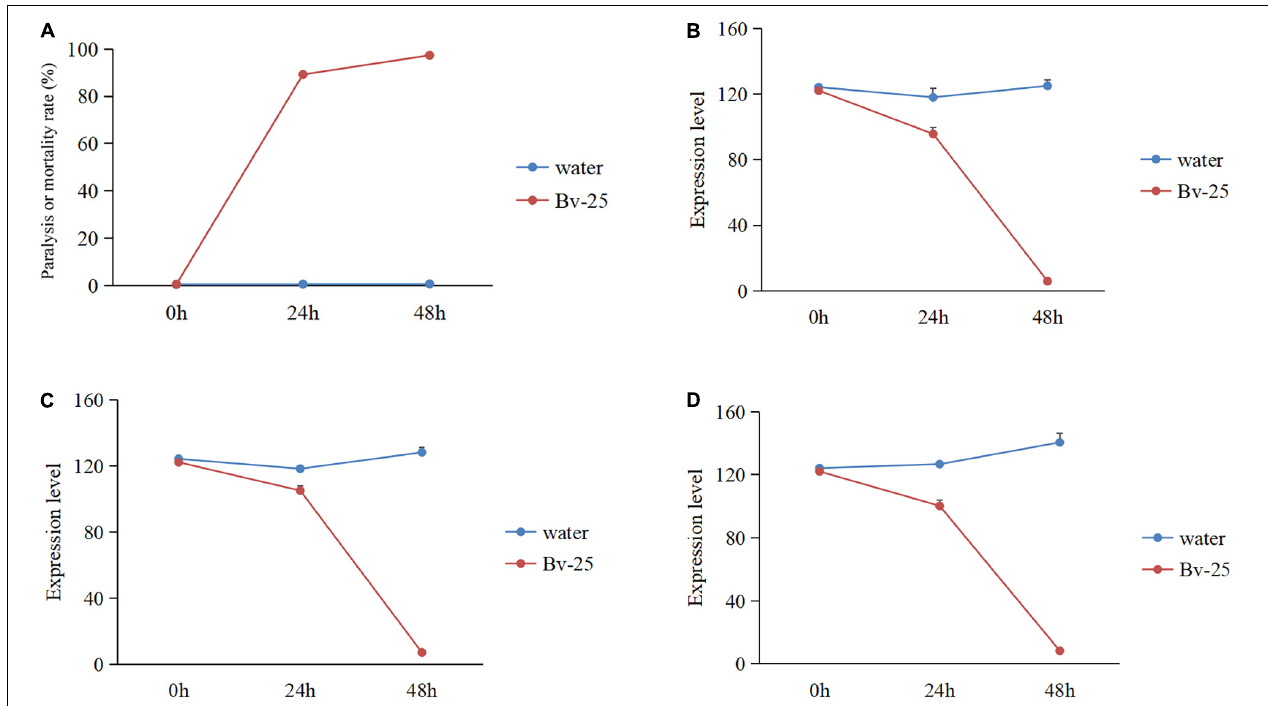
FIGURE 3 | The nematicidal activity and gene expression pattern of J2s under Bv-25 fumigation. (A) The paralysis or mortality rate of J2s treated by Bv-25 fumigation. (B) The ord-1 gene expression pattern. (C) The mpk-1 gene expression pattern. (D) The flp-1 8 gene expression pattern.